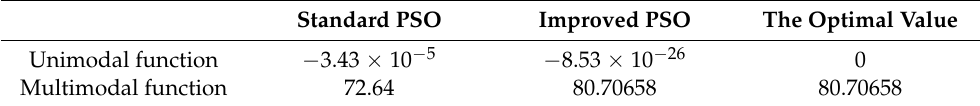
Table 1. Comparison of PSO optimization results before and after improvement.